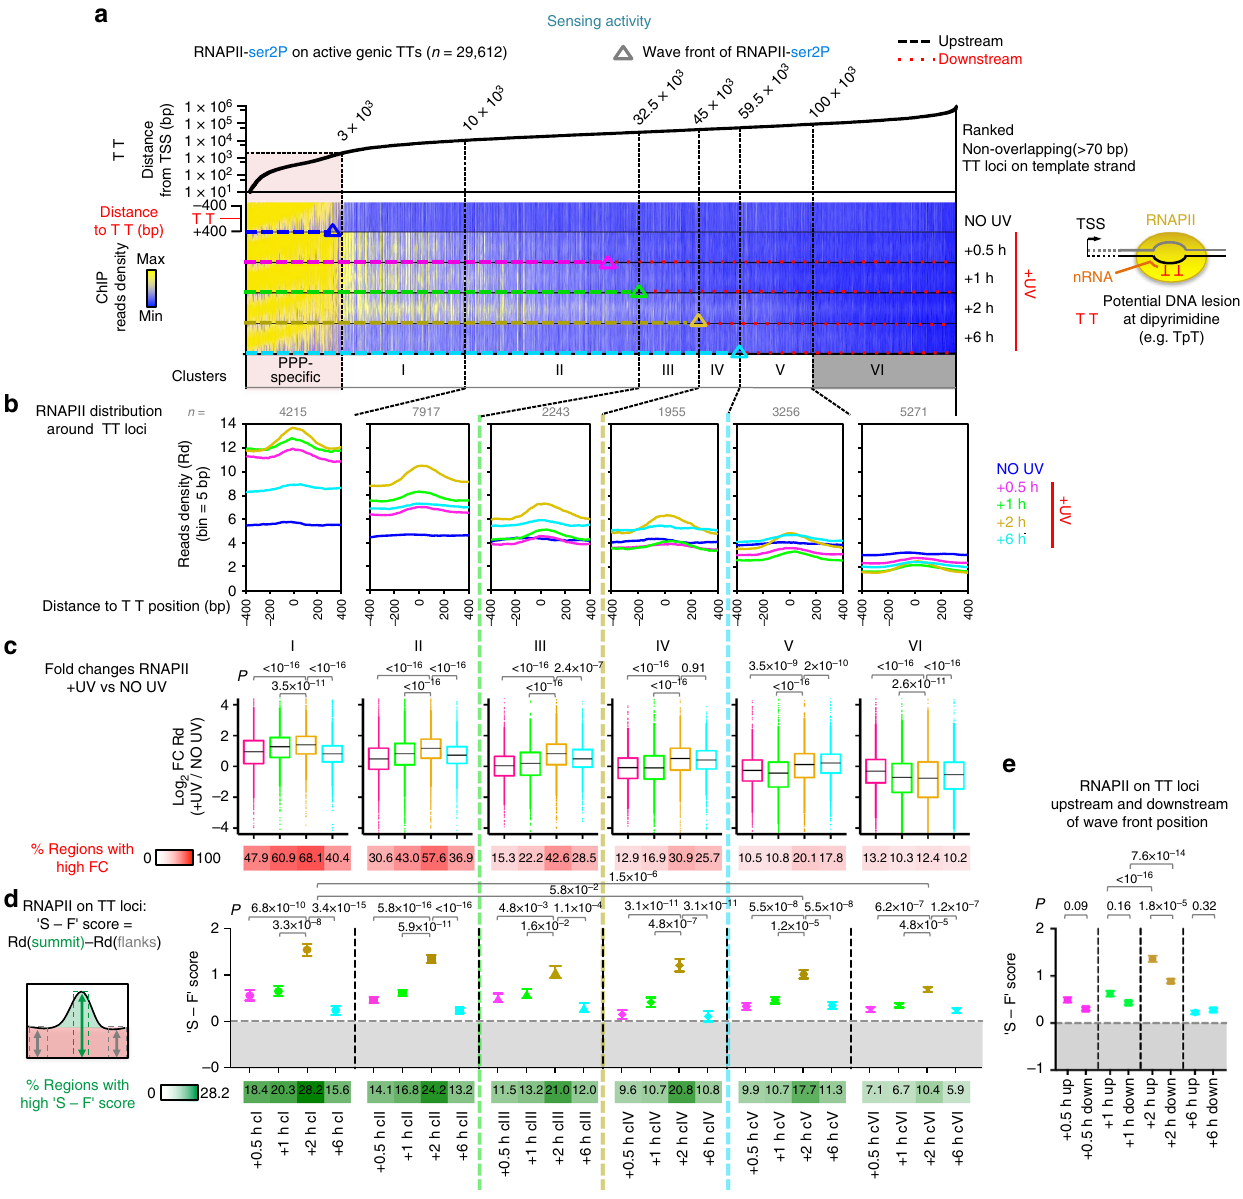
Fig. 4 RNAPII-dependent sensing of DNA lesions is enhanced by the de novo wave-release. a Heatmaps illustrating the distribution of RNAPII-ser2P reads aligned around TT loci localized in active genes (as de fi ned in Supplementary Fig. 8a) before (NO UV) and after UV irradiation (+UV, 8 J m − 2 ) and sorted from left to right by increasing distance relative to TSS. TT loci were clustered (upstream (i.e. Clusters I, II, III for +2 h) or downstream (i.e. Clusters IV, V, VI for +2 h)) relatively to RNAPII-ser2P wave front positions, which indicate the transition state from de novo-enriched to pri-elongating only population of RNAPII (see Fig. 1e, Supplementary Fig. 8d and Methods for details). TT loci near PPP-speci fi c RNAPII signal were not considered for analysis. b Average plots of read densities (Rd) as mapped in a for individual clusters ( n is indicated). c Top; box plots showing the changes in Rd in regions analysed in b and normalised by Rd of NO UV ( P value based on two-sided t -test using the Benjaminin – Hoechberg (BH) adjustment). Boxes refer to the fi rst quartile, the median and the third quartile. Whiskers refer to the 10 – 90% interquantile range. Bottom; heatmap representing the proportion of regions (per cluster) with high fold changes (FC > 2) in Rd. d Top; plot showing the average ( ± SEM) of the difference between Rd at summit and Rd at fl anks (de fi ned as ‘ S - F ’ score) of all regions analysed in b ( P -value based on two-sided Wilcoxon rank-sum test the BH adjustment). Bottom; heatmap representing the proportion of regions (per cluster) with high ‘ S - F ’ scores ( > threshold = average[S - F] exon start + 3×SD[S - F] exon start , see Supplementary Fig. 9 and Methods). e Plot showing the comparison of average ( ± SEM) ‘ S - F ’ score for all regions upstream (Up) and downstream (Down) of the respective wave front position, for each time of recovery ( P -value based on two-sided Wilcoxon rank-sum test using BH